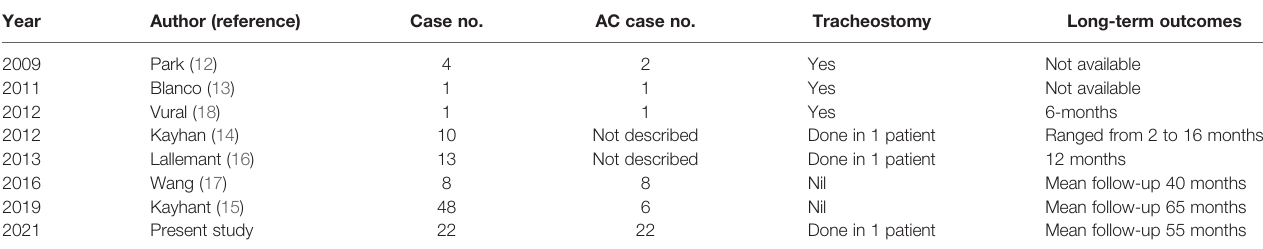
TABLE 4 | TORS for glottic ca with or without AC involvement in literature.